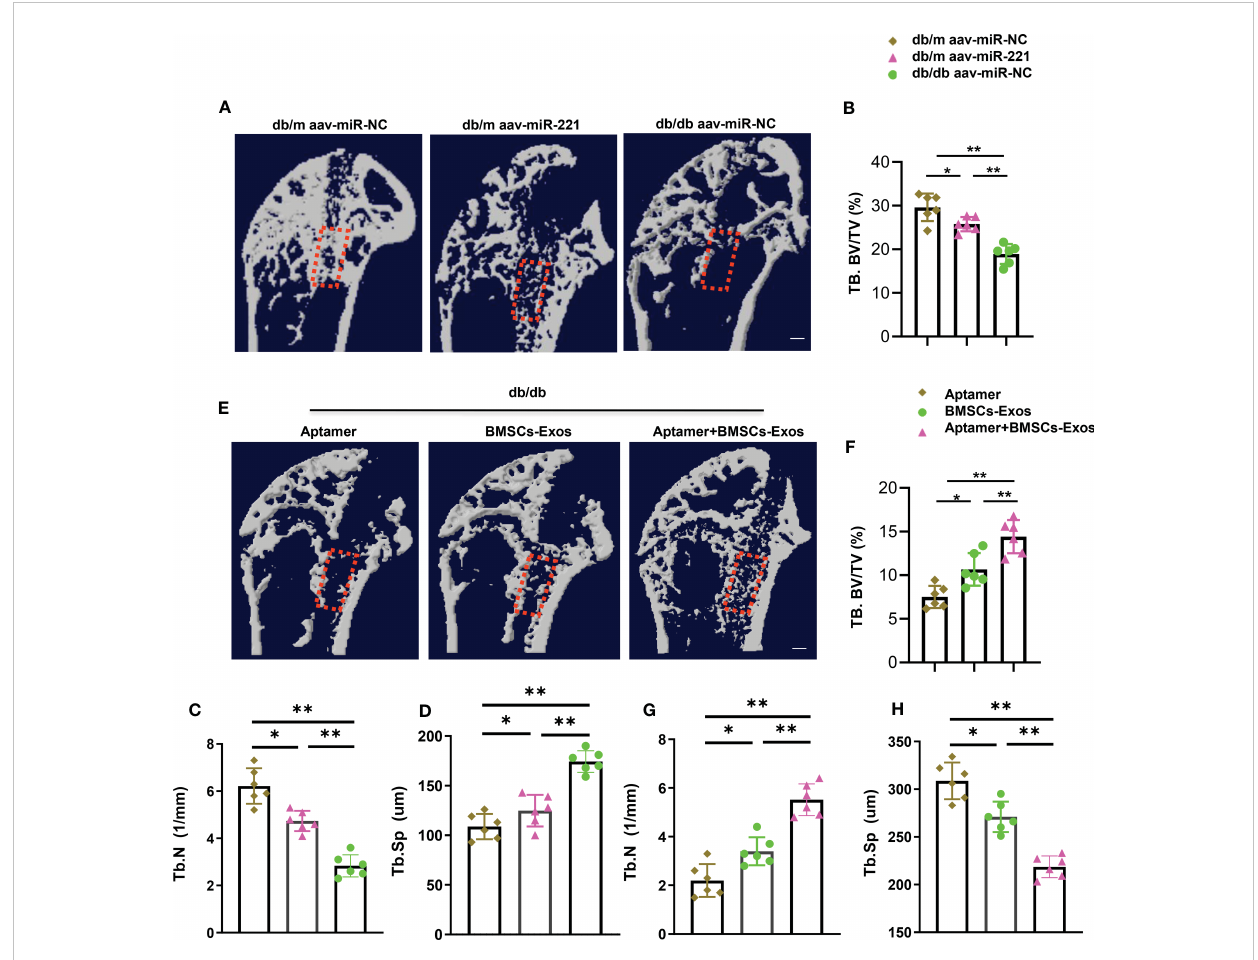
FIGURE 8 Aptamer-BMSCs-Exos promoted bone regeneration in diabetic mice. Using a dental drill to place a 0.6mm diameters Kirschner wire at the proximal end of the femur. A week after, separate the femur and tibia under aseptic conditions for further micro-CT analysis. (A, E) Representative micro-CT images; Scale bar: 1mm. (B-D, F-H) Quantitative analysis of bone regeneration after femoral trabecular bone ablation of 3-month-old diabetic and normal mice. Selected areas for the measurements of bone volume/tissue volume (BV/TV) were indicated with a red square. The data is shown as the mean ± SD. n = 6 per group, * P <0.05 ** P < 0.01,